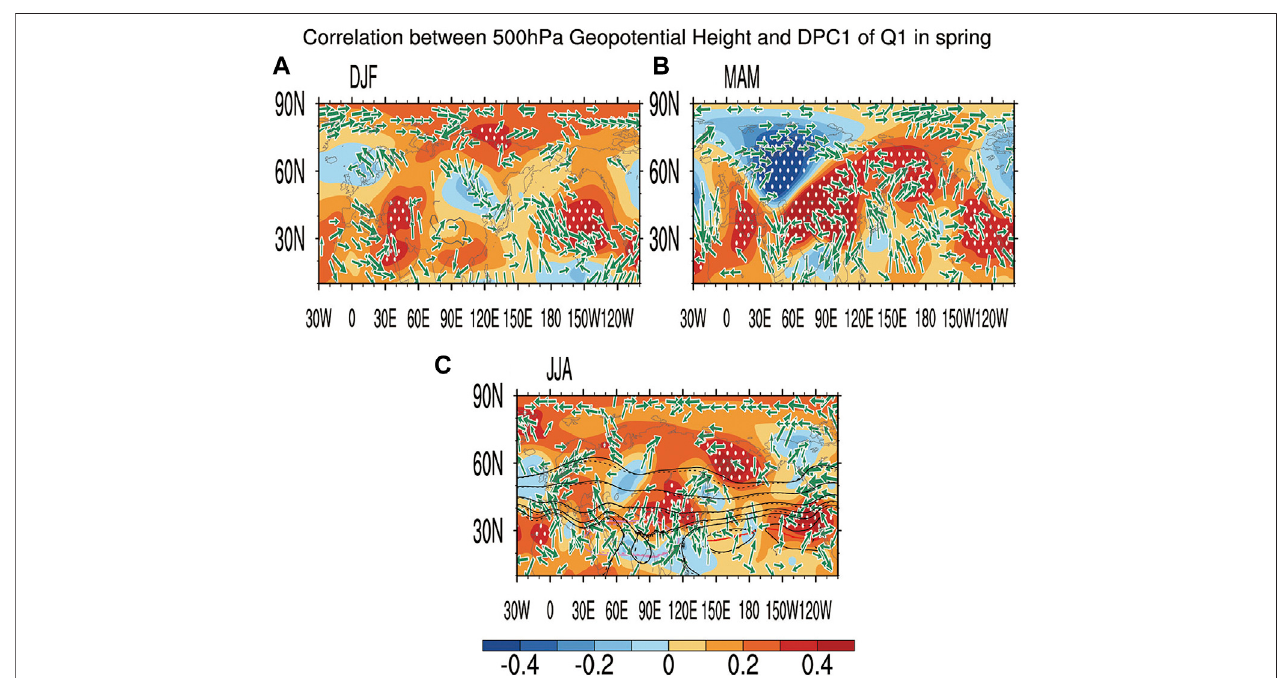
FIGURE 11 | Distribution of the correlation coef fi cients between DPC1 and 500 hPa geopotential height (shading; gpm) and vector resultants of correlation coef fi cient between DPC1 and the 300 hPa T-N wave activity fl ux (arrows; m/s) in the time period 1979 – 2020 in (A) previous winter, (B ) spring and (C) summer. The whitedotsindicatestatisticalsigni fi canceatthe95%con fi dencelevel.Inpart (C) ,theblacksolid/dashedlinesarethecompositegeopotentialheightcontoursinsummer of DPC1 high (DPC1 > 1)/low (DPC1 < − 1) years (only the 5,860, 5,840, 5,800, 5,720, and 5,640 gpm lines are shown). The red solid/dashed lines are the compositesubtropicalhighinsummerofDPC1high(DPC1 > 1)/low(DPC1 < − 1) years.Thepurplelinesarethecomposite12,500contouroftheDPC1high(DPC1 > 1)/ low (DPC1 < − 1) in summer (the South Asian high-pressure range). Vectors are plotted as arrows only when statistical signi fi cance of zonal component of T-N wave activity fl ux is at the 90% con fi dence level. A positive correlation for zonal or meridional component is denoted by an eastward or poleward arrow,